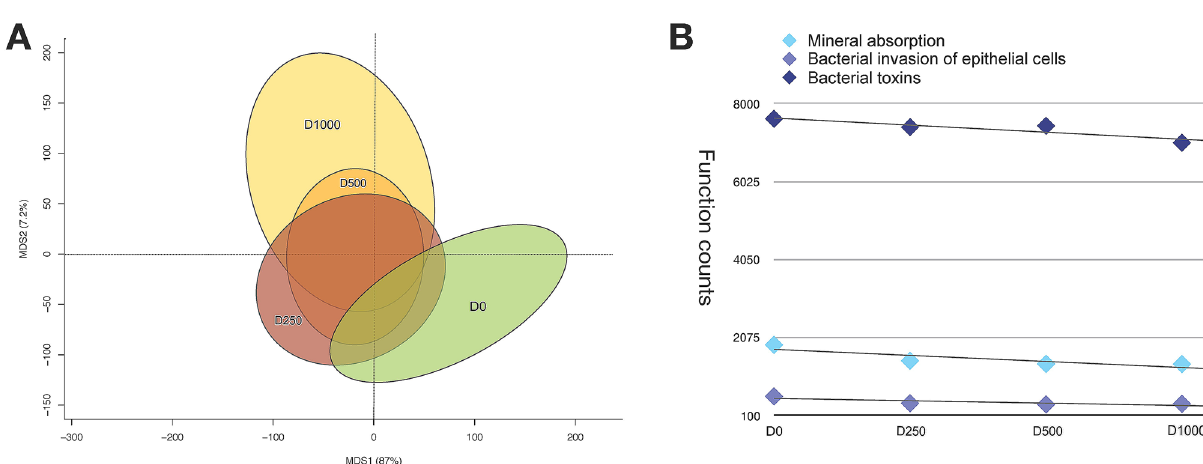
Figure 4. Profile of putative functions encoded by the sea bass gut microbial community during the diet intervention (D0, D250, D500, D1000). Principal Component Analysis (PCA) based on Euclidean distance between samples is reported in ( A ). A significant separation among groups was observed [P value = 0.04— Permutation test with pseudo-F ratios (Adonis)]. ( B ) D1000 promotes a significant decrease in several inflammation-promoting and homeostatic functions, such as bacterial invasion of epithelial cells ( P = 0.01— Wilcoxon rank-sum test), bacterial toxins ( P = 0.01—Wilcoxon rank-sum test) and mineral absorption ( P = 0.02—Wilcoxon rank-sum